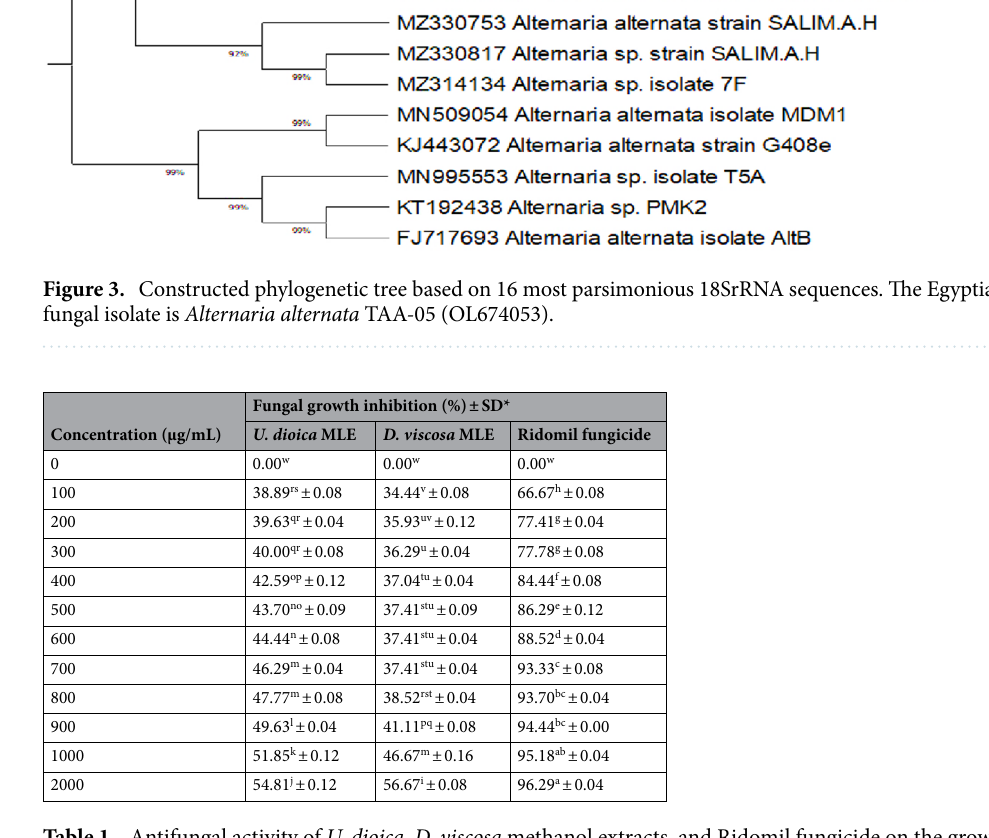
Table 1. Antifungal activity of U. dioica , D. viscosa methanol extracts, and Ridomil fungicide on the growth of A. alternata isolate in vitro conditions. *Standard deviation. Means with the same letter/s are not significantly different according to LSD at 0.05 level of